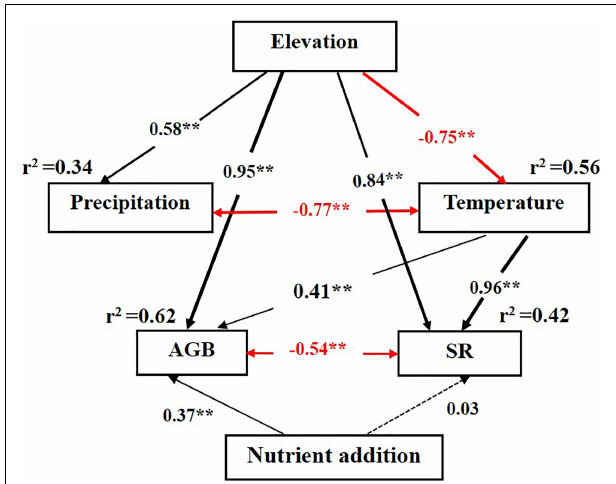
FIGURE 4 | Structural equation model for the effect of environmental factors and nutrient inputs on the plant above-ground biomass. Red and black arrows indicate positive and negative relationships, respectively. Single-headed arrows represent causal relationships and two-headed arrows indicate correlation. Dotted arrows represent non-significant paths ( p > 0.05). Values adjacent to arrows indicate standardized path coefficients. The proportion of variance explained ( r 2 ) appears alongside response variable in the model. Significance levels are denoted with ** p <